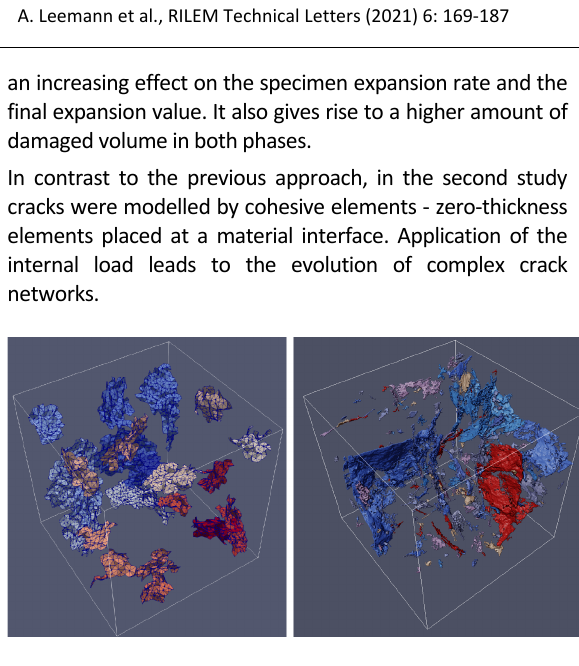
Figure 17. Numerically computed cracks in concrete specimen (on the left) next to their experimental counterpart.